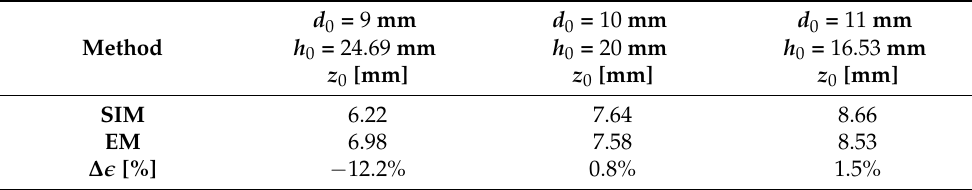
Table 6. The impact of the PM’s geometry proportion ( d 0 / h 0 ) on its equilibrium height.